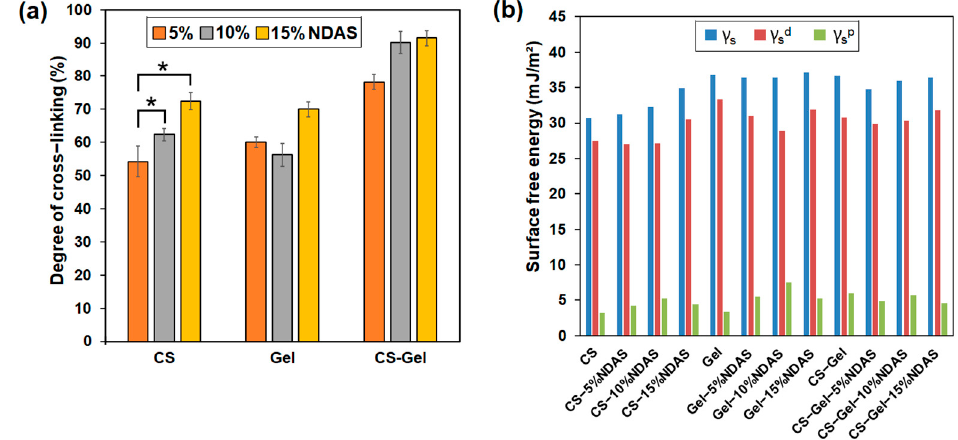
Figure 4. ( a ) Degree of cross-linking of chitosan (CS), gelatin (Gel), and chitosan–gelatin (CS-Gel, 1:1) cross-linked by 5%, 10%, and 15% cross-linker; statistical significance is indicated with asterisks: * p < 0.05. ( b ) The surface free energy ( γ s ) and its polar ( γ sp ), and dispersive ( γ sd